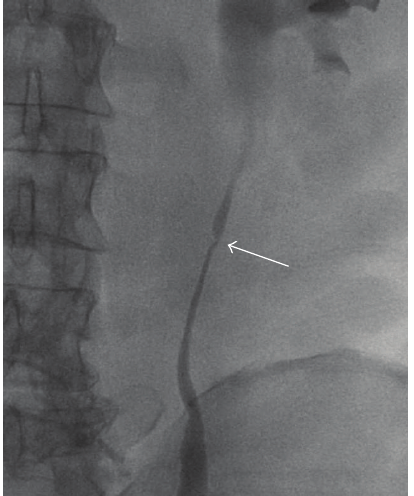
Figure 3: Retrograde ureteropyelography showing ureteral stenosis at the L3 vertebral level.